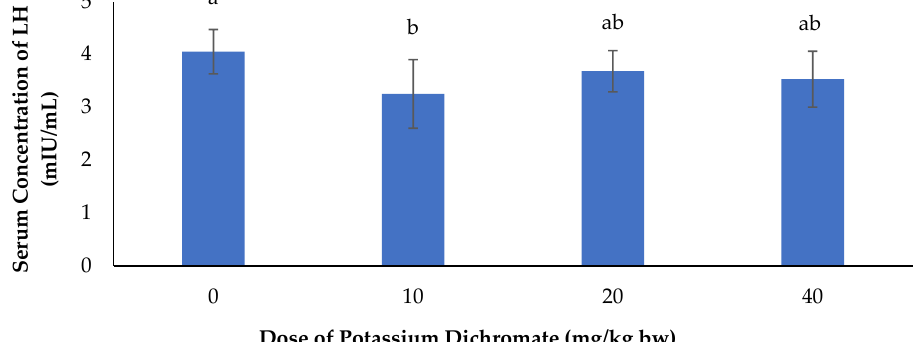
Figure 2. Effects of potassium dichromate on serum concentration of FSH in rabbit does. a,b: bars affected with the same letter do not differ significantly ( p > 0.05).